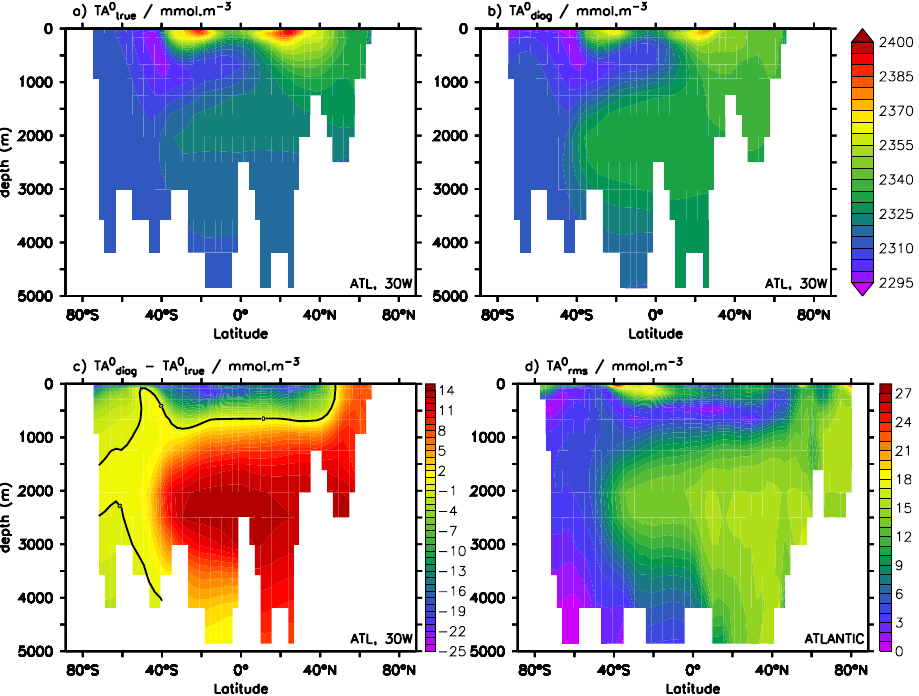
Figure 9. TA 0 distribution in the Atlantic Ocean from explicit tracer (a) and computed from winter biased surface sampling (b) . Panel (c) shows the anomaly between the two and panel (d) the basin average RMSE of TA 0 .